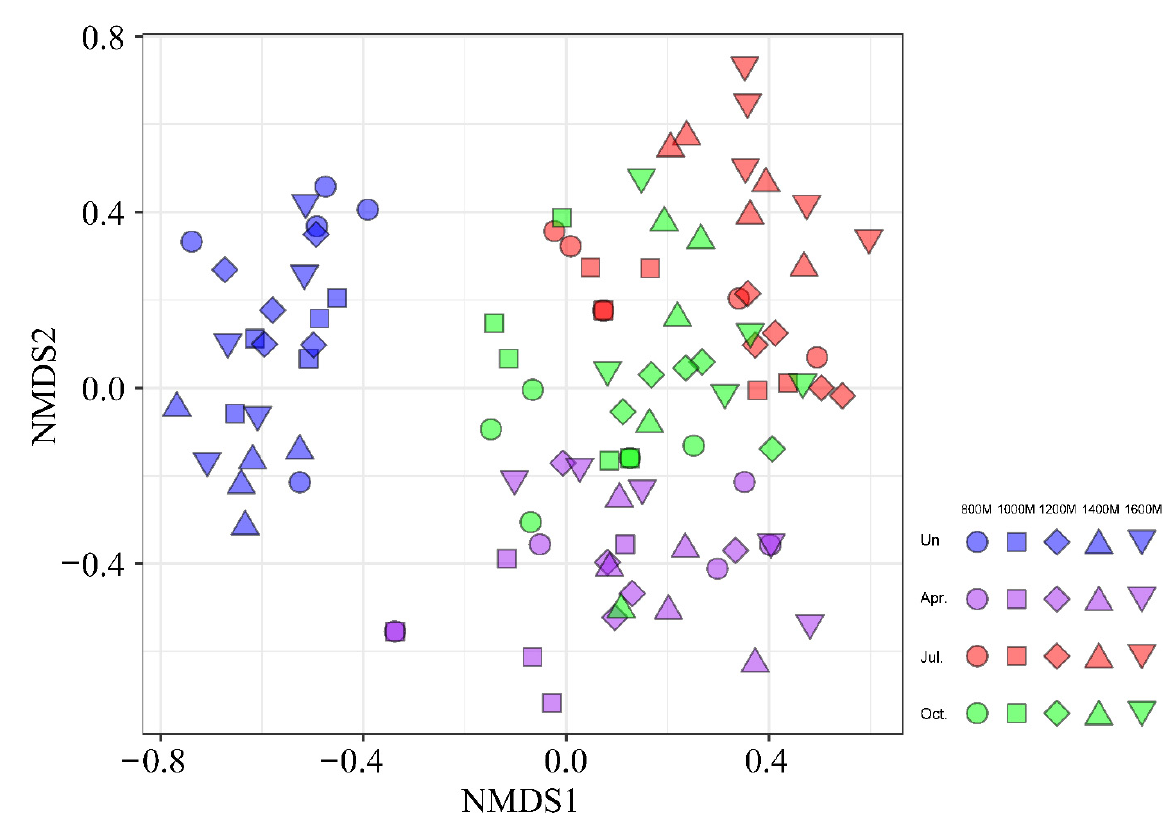
Figure 7. Two-dimensional nonmetric multidimensional scaling (NMDS) ordination of understory vegetation and seed banks along an elevational gradient (800, 1000, 1200, 1400 and 1600 m) in April, July and October (stress value = 0.1901). The marks change with the seasons, and the colors represent understory vegetation and seed banks during different seasons (Un—understory).